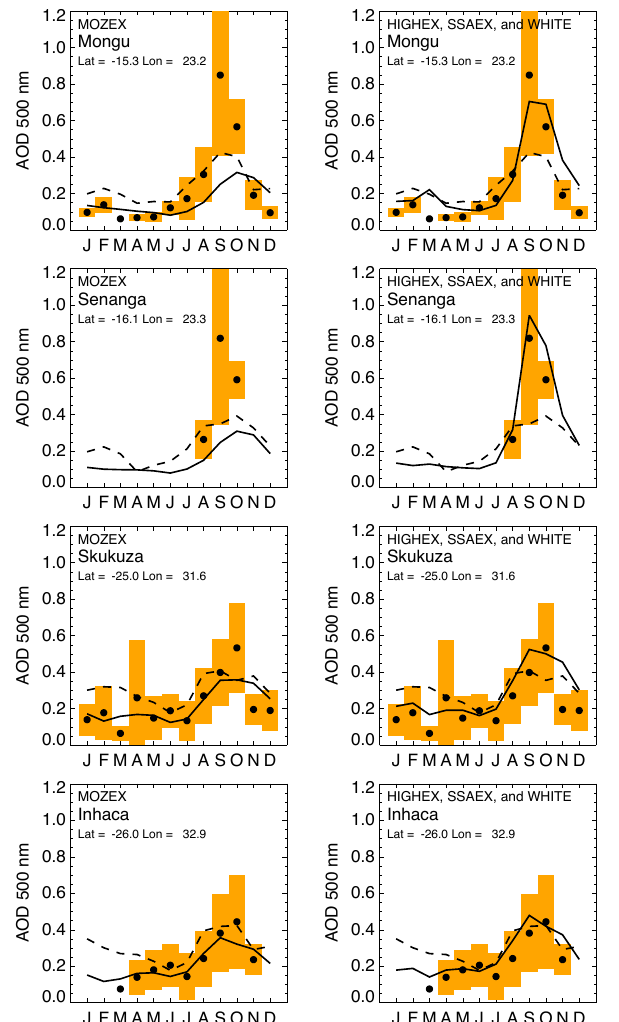
Fig. 3. Comparison of simulated (solid black lines) AOD to monthly-mean climatological observations from AERONET (black dots; orange bars are standard deviation) and MODIS retrievals (dashed lines; 2002–2004 average). Left column is for MOZEX and right column is for experiments with OC and BC mass adjusted to match observationally-based maps of AOD (i.e. HIGHEX, SSAEX, and WHITE). Mongu and Senanga lie in the primary biomass burn- ing region ( ∼ 0–17 ◦ S) during the dry season